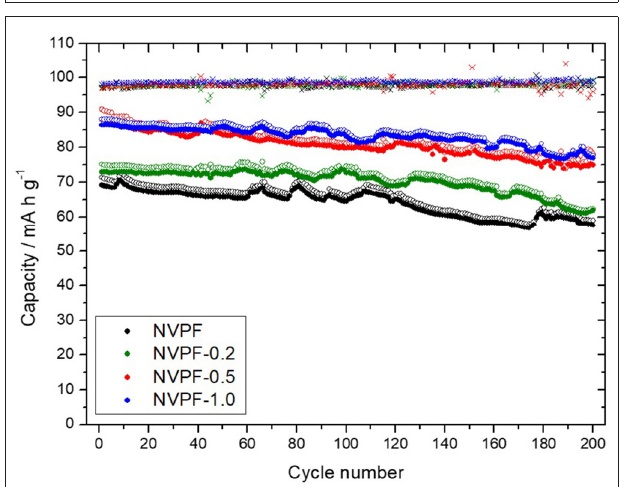
FIGURE 9 | Extended galvanostatic cycling at 1C NVPF-0.5 (open symbols: charge capacity; closed symbols: discharge capacity).